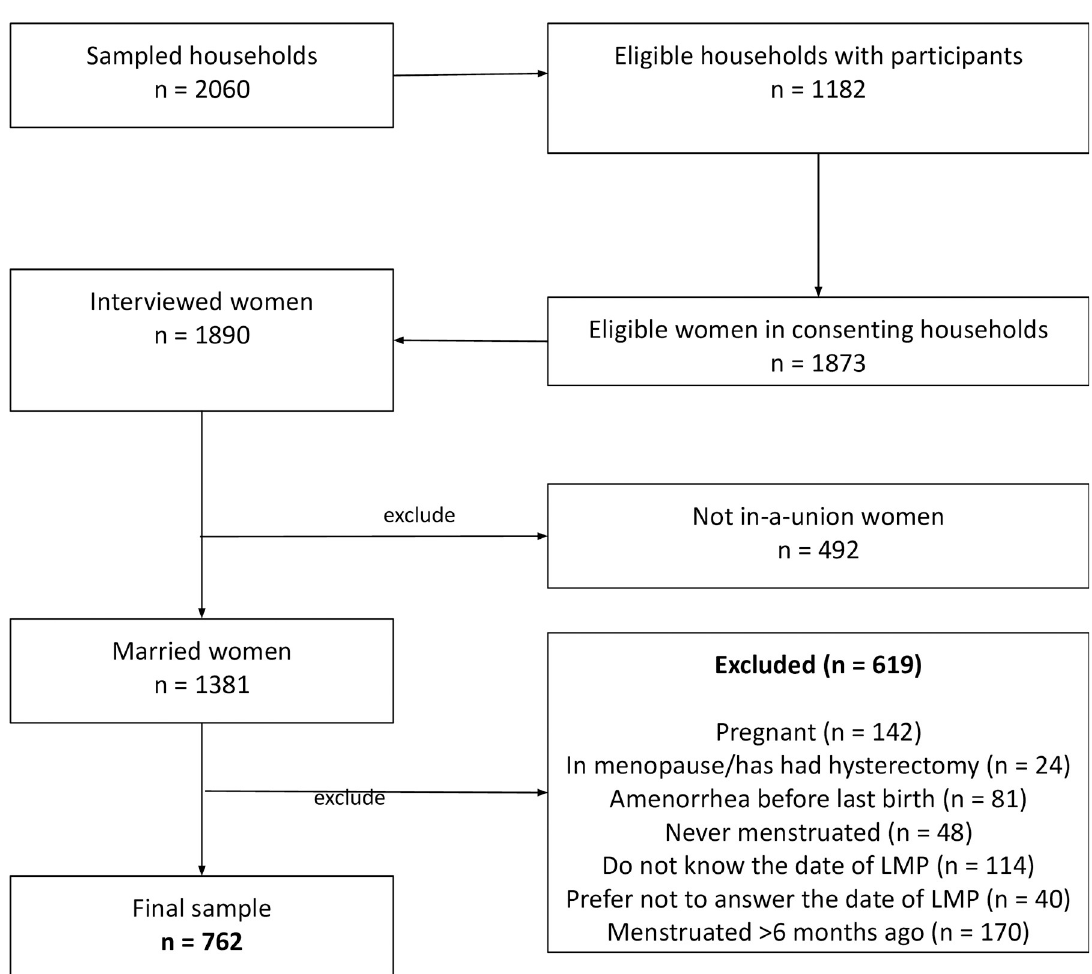
Fig 2. The population of the women aged 15–49 years included and excluded in the baseline